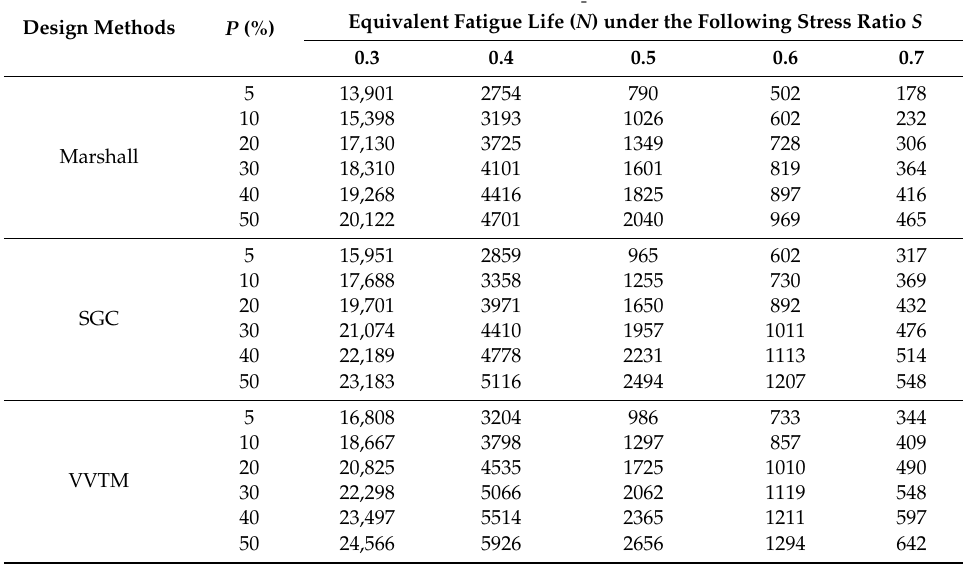
Table 18. Equivalent fatigue lives of the specimens at di ff erent failure